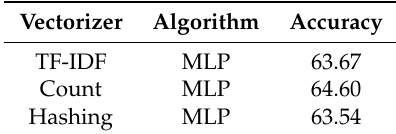
Table 9. Testing Score for Marglish